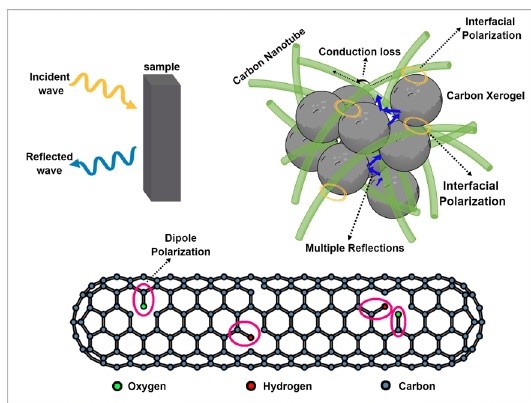
Figure 11. Illustration of the EW absorption mechanisms in the CX/CNT